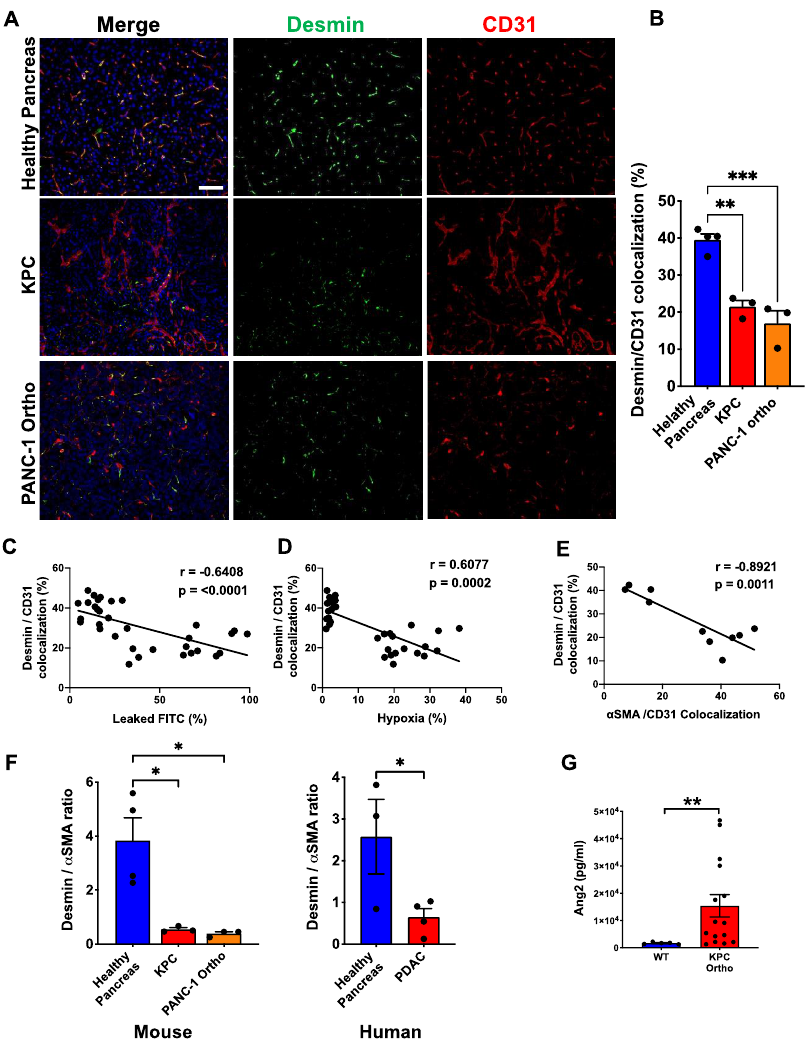
Figure 3. Desmin low / α SMA high phenotype is correlated with vessel leakiness and hypoxia. ( A ) Rep- resentative images of FFPE sections of KPC and PANC-1 tumors, and healthy pancreas immuno- labeled for Desmin and CD31. Sections are counterstained with DAPI (blue) to visualize nuclei. ( B ) Quantification of percentage of CD31 + vessels associated with Desmin + pericytes. (WT n = 4; KPC and PANC-1 ortho-tumors n = 3). One-way ANOVA with Dunnett’s multiple comparisons was used to determine statistical significance. ( C ) Correlation of FITC-dextran leakage and Desmin + pericyte-covered vessels ( n = 6). ( D ) Correlation of hypoxic area and Desmin + pericyte-covered vessels ( n = 6). ( E ) Correlation of Desmin + pericyte and α SMA + pericyte-covered vessels ( n = 10). Pearson’s r correlation coefficient and significance levels are presented. ( F ) The ratio of Desmin + pericyte and α SMA + pericyte per each tissue section was compared between the healthy pancreas and PDAC tumors for both murine models and humans. ( G ) Plasma Ang2 level was compared between KPC tumor-bearing mice and healthy mice using the Ang2 ELISA kit. Unpaired two-tailed t -test was used to determine statistical significance. Scale bar: 100 µ m; apply to all images. Unless otherwise stated, the data are represented as the mean ± SEM. * p < 0.05, ** p < 0.01, *** p <